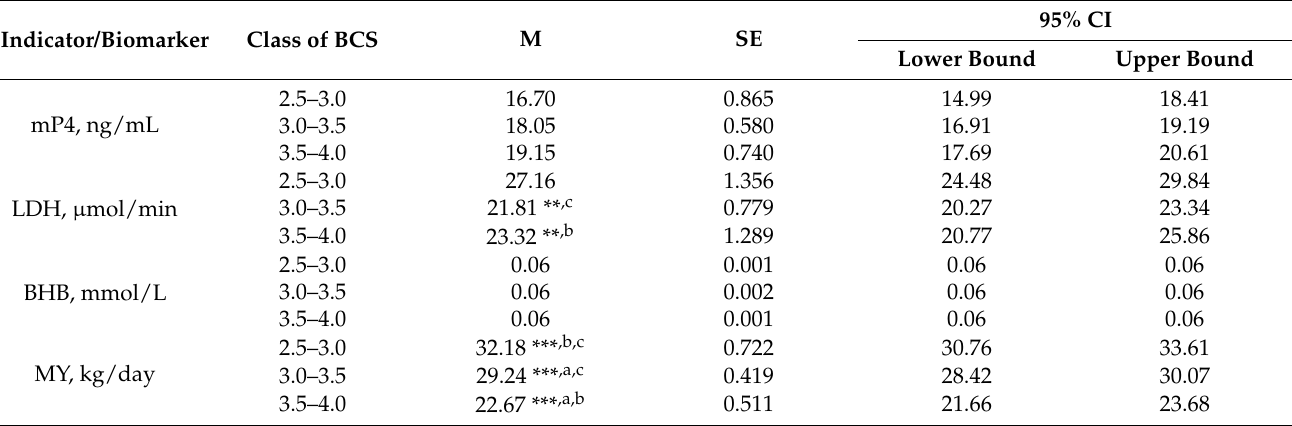
Table 2. Means and standard errors of the mean of biomarkers based on the body condition score from the day of oestrus to 7 days